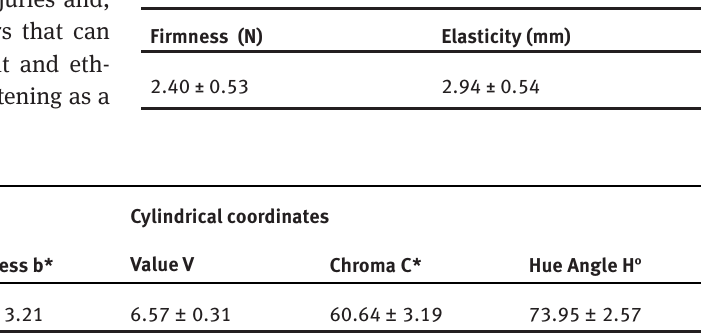
Table 3: Texture characteristics of